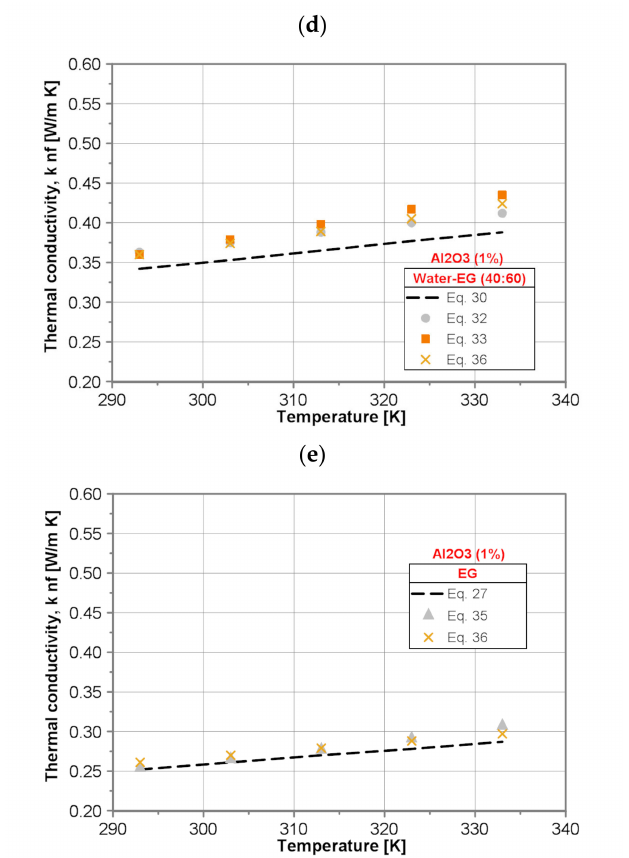
Figure 8. Comparison of thermal conductivity of the tested nanofluids with 1% nanoparticle mass concentration: ( a ) water / Al 2 O 3 , ( b ) water / EG (60:40) / Al 2 O 3 , ( c ) water / EG (50:50) / Al 2 O 3 , ( d ) water / EG (40:60) / Al 2 O 3 and ( e ) EG-Al 2 O